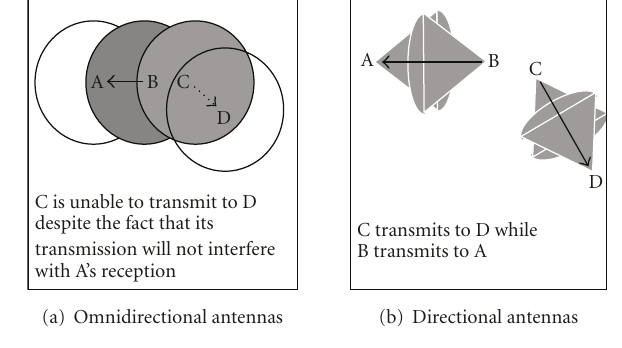
Figure 2: The exposed terminal